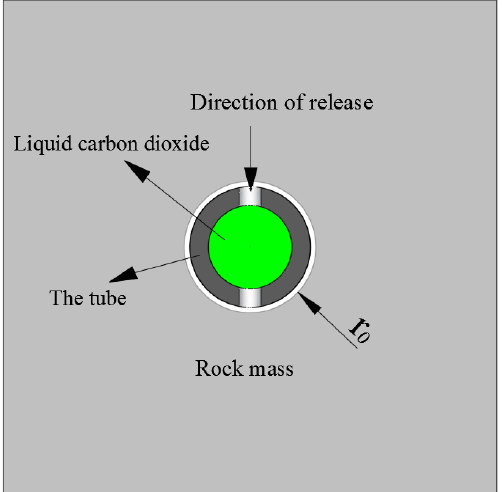
Figure 3. Schematic diagram of the borehole when the cracker is placed.